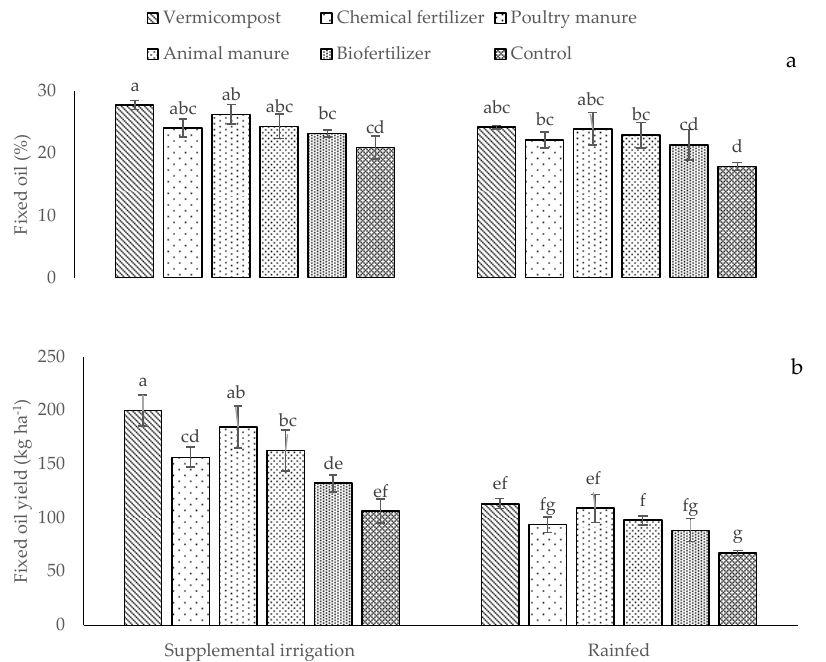
Figure 8 . Means (±Standard deviation, SD) assessment for the interaction impacts of fertilizer and irrigation conditions on fixed oil percentage ( a ) and fixed oil yield ( b ). The means with unlike letters vary significantly at p ≤ 0.05 based on Tukey’s HSD test.